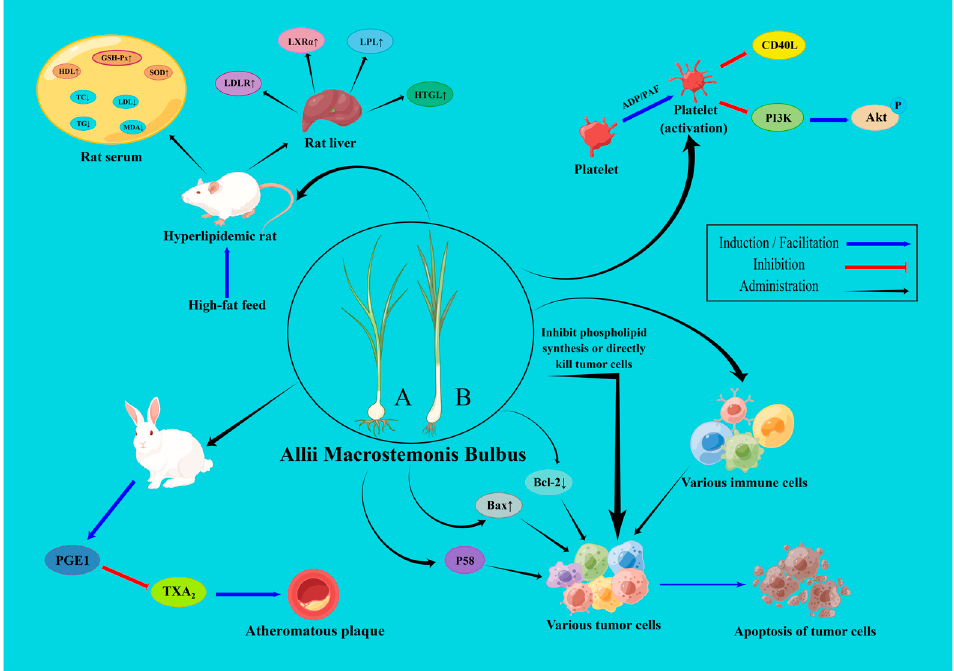
Figure 7. The pharmacological mechanism of AMB (Partial): A. macrostemon ( A ) and A. chinense ( B ). (www. fi gdraw.com, accessed on 28 February 2023).